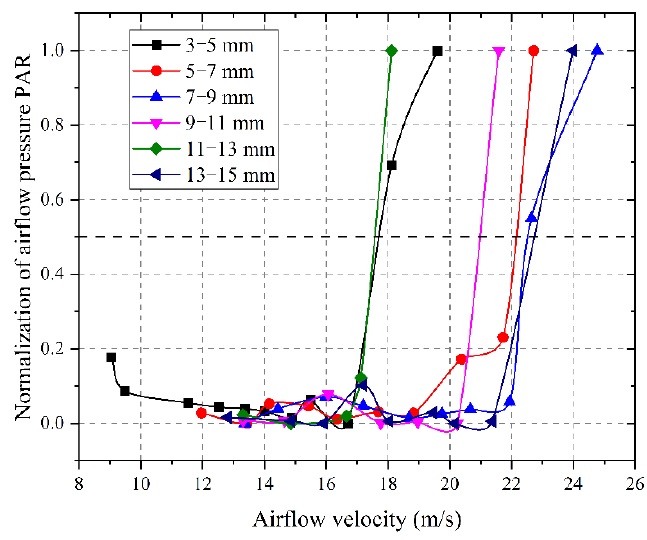
Figure 13. Relationship between peak-to-average rate and airflow velocity.